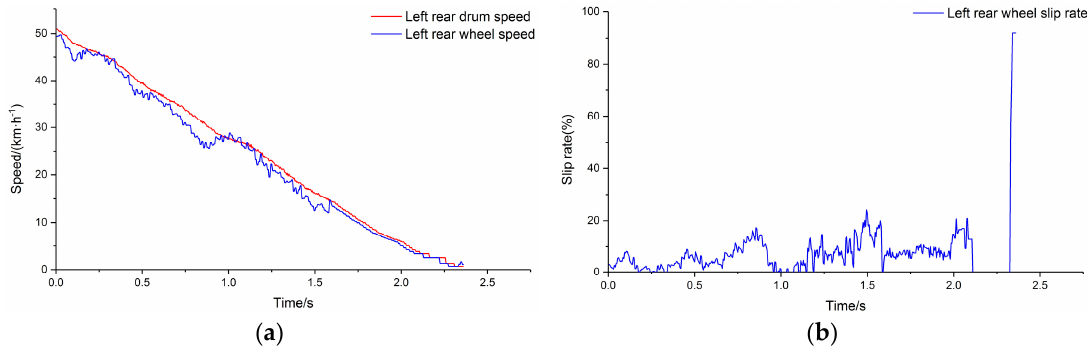
Figure 17. ( a ) Comparison of main drum speed and wheel speed; ( b ) slip rate.